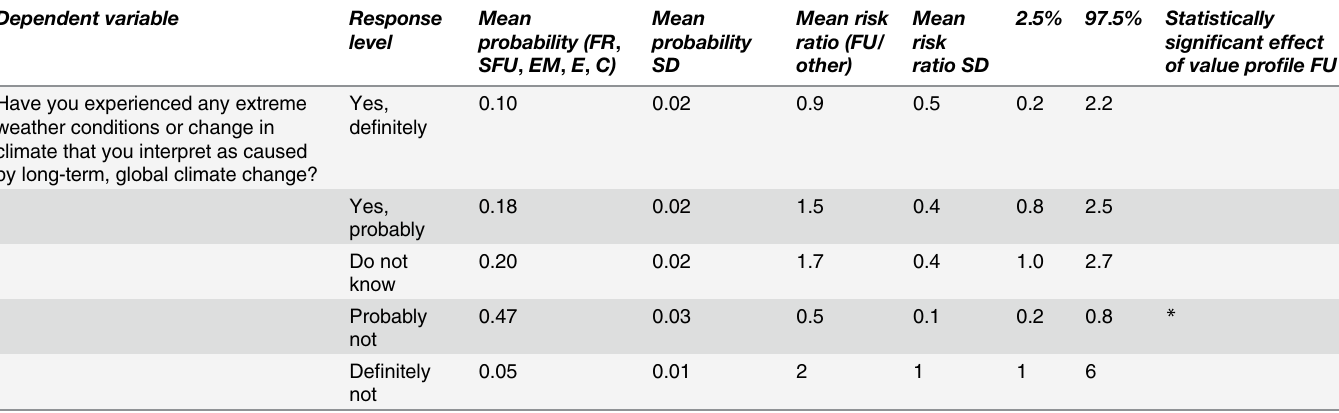
Table 6. Predicted probabilities for strengths of belief in having experienced the effects of climate change based on value profile and relative risk ratios for strengths of belief in having experienced the effects of climate change based on value profile (Forest users/other) among Swedish respondents (S7 Table).